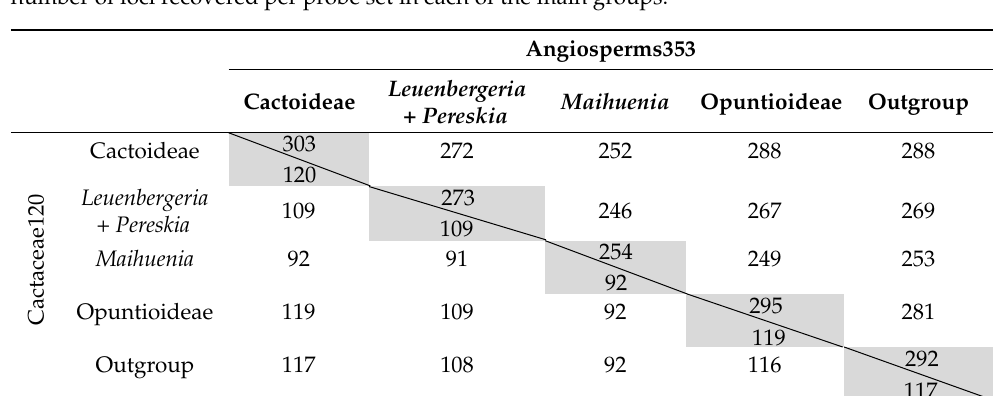
Table 2. Comparison of loci recovered per probe set and main group in Cactaceae. Numbers in white cells represent the number of loci shared between main groups in Angiosperms353 (above the diagonal line) and Cactaceae120 (below the diagonal line). The gray diagonal cells correspond to the number of loci recovered per probe set in each of the main